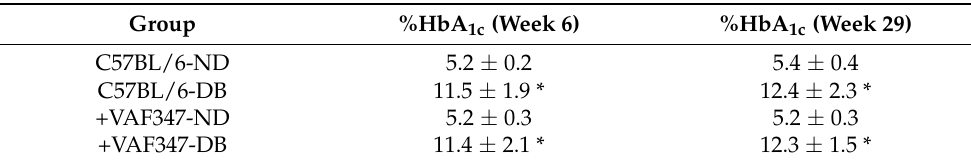
Table 1. Glycated Hemoglobin A 1c Data of Non-Diabetic (ND) and Diabetic (DB) Mice.